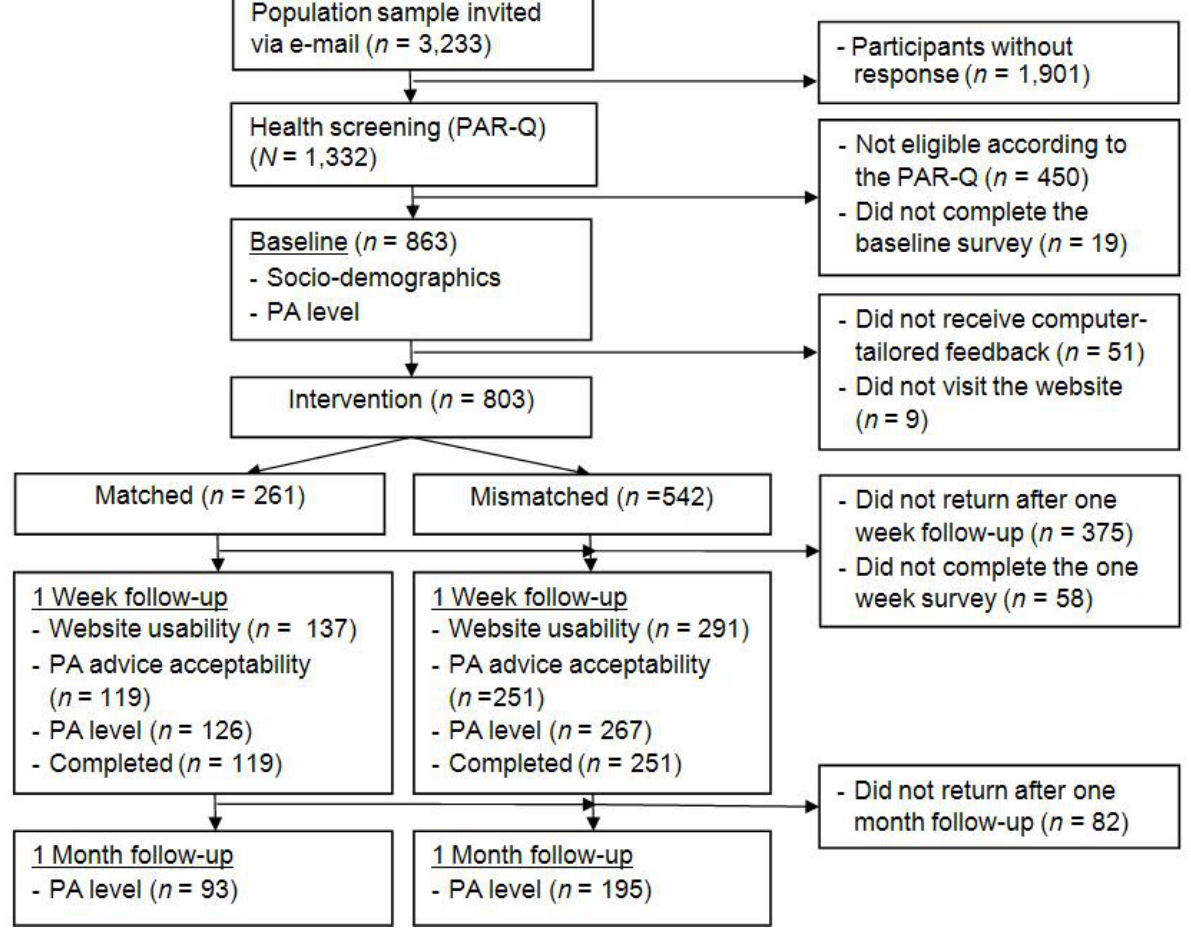
Figure 1. Participant flow. PA = physical activity; PAR-Q = Physical Activity Readiness